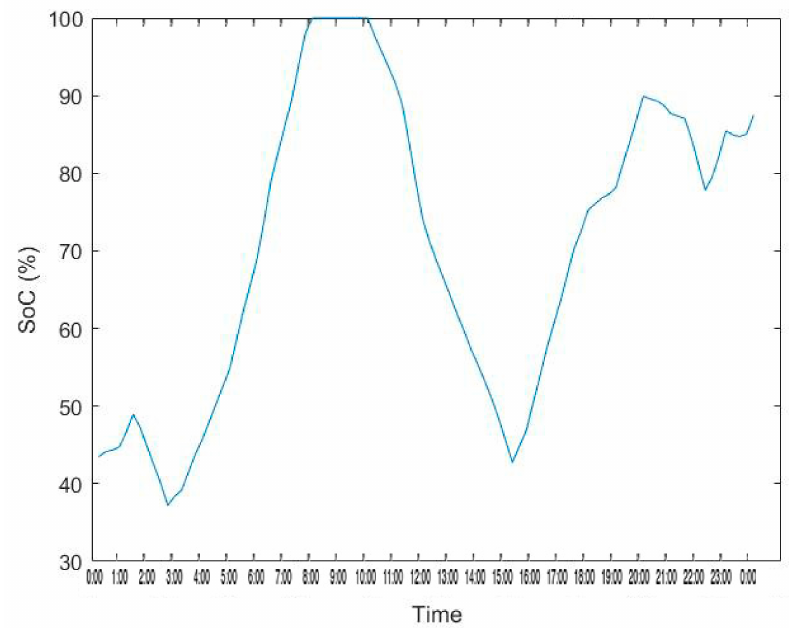
Figure 19. State of charge of Street Battery in PCLU.